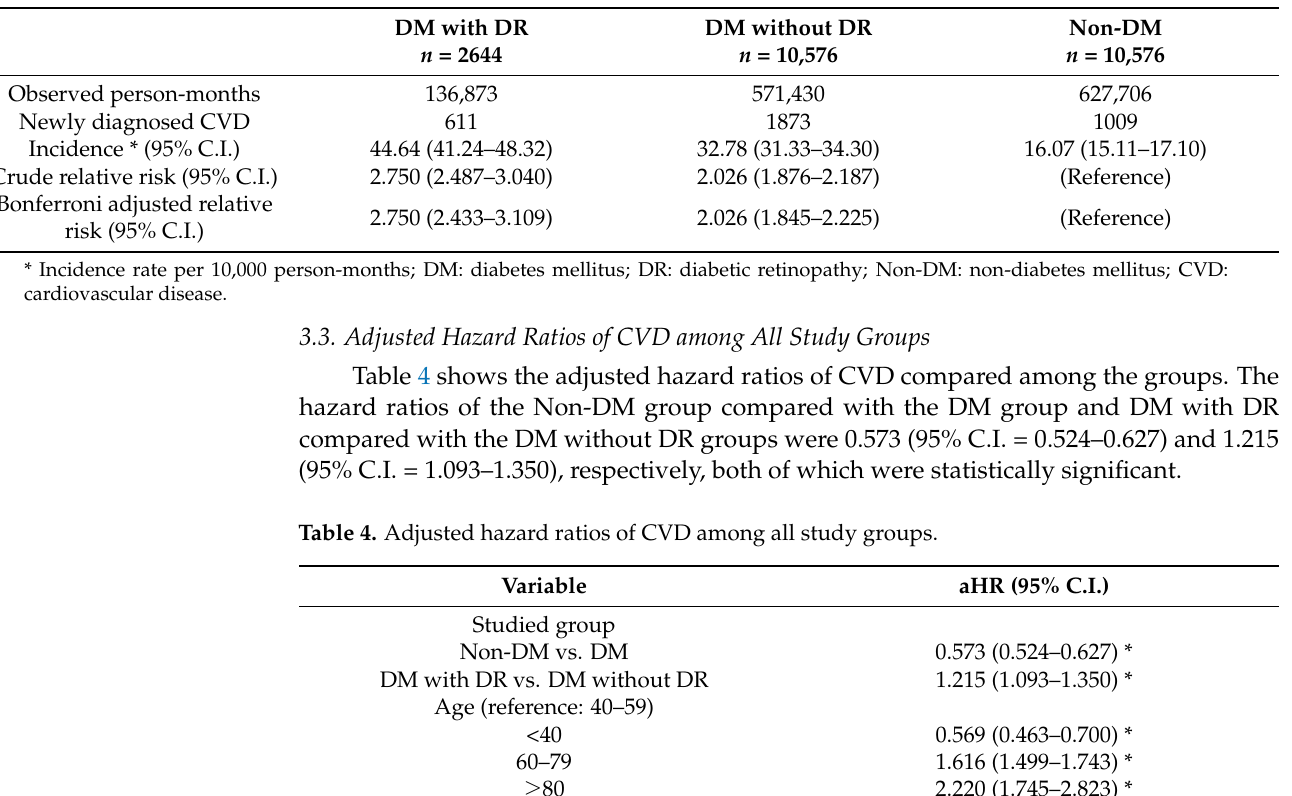
Table 3. Incidence of cardiovascular disease in the examined groups.